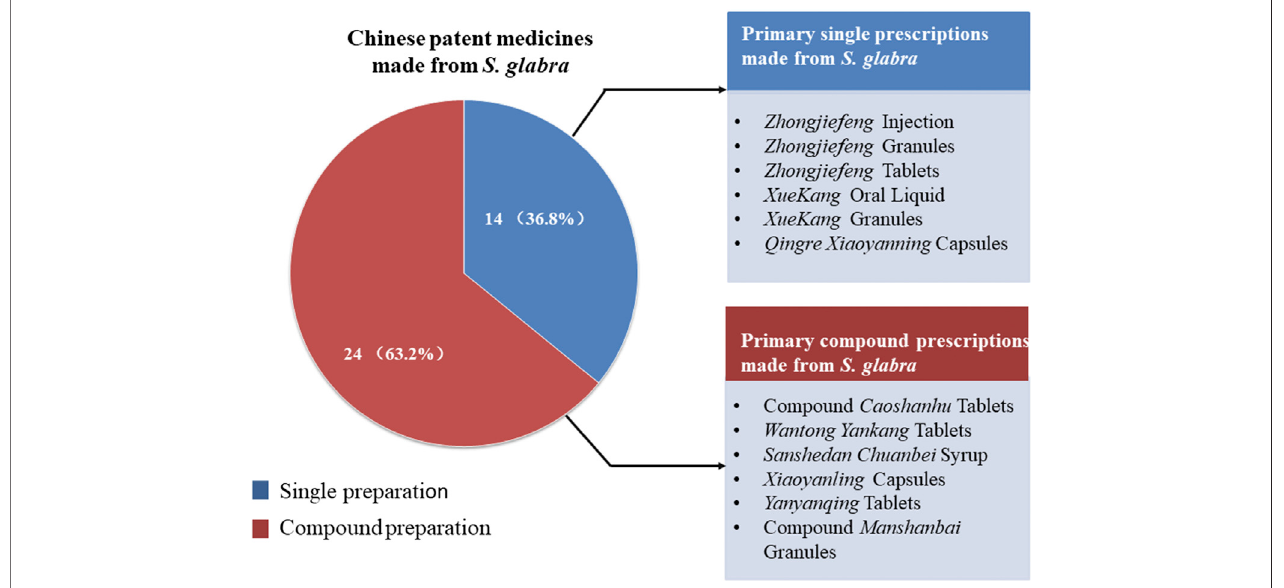
FIGURE 1 | Chinese patent medicines made from S. glabra